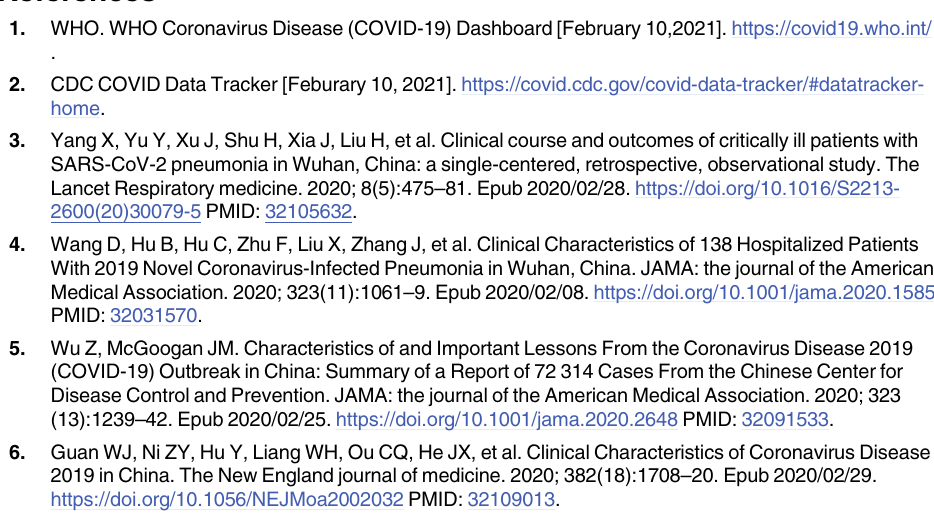
S5 Table. Soluble marker levels. (PDF) S1 Fig. CyTOF gating schema. S2 Fig. Hierarchical clustering of soluble